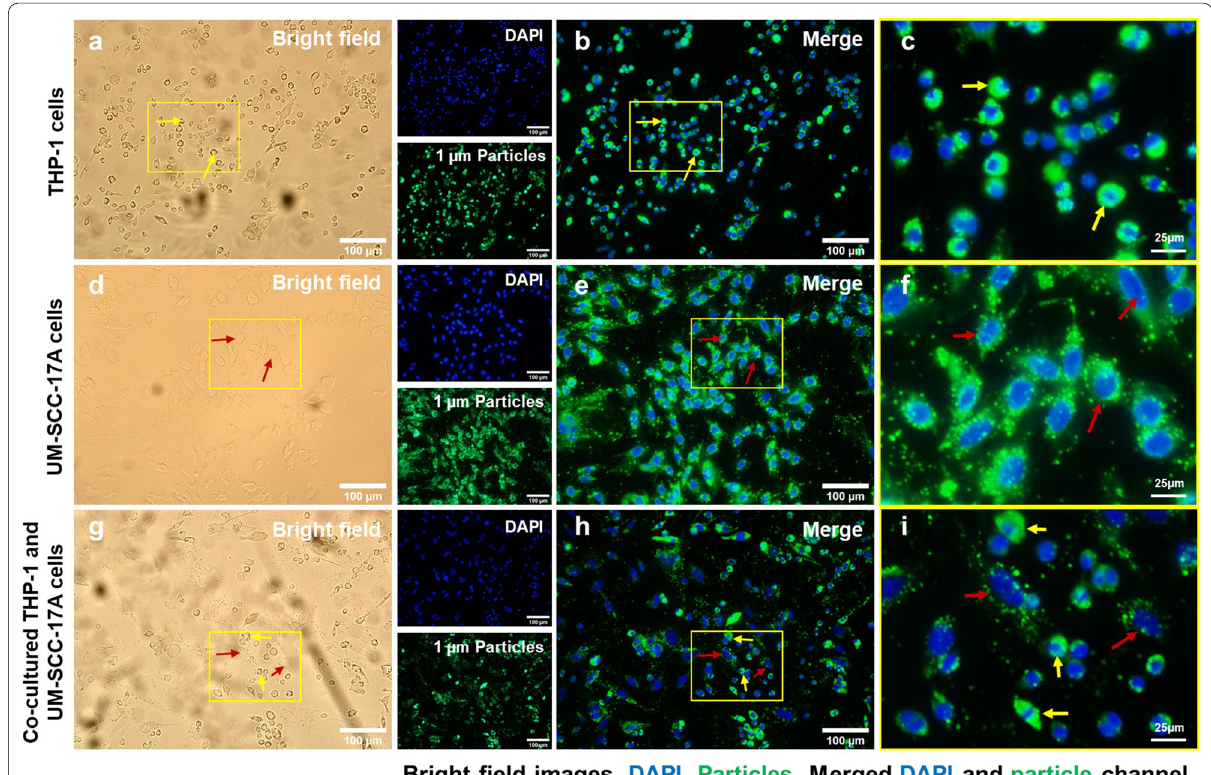
Fig. 6 Microscopic examination of cellular internalization of 1 µm PLGA particles in monoculture and co‑culture cells. Single type of cells or mixed cells was treated with 1 µm PLGA particles for 24 h at a concentration of 10 µg/mL. Cells were observed under bright‑field ( a , d , g ) and fluorescent channels ( b , e , h ) with particles observed at the green channel and cell nuclei in the blue channel after stained with Hoechst. A large amount of particle uptake and tremendous accumulation of 1 µm PLGA particles can be visualized in magnified images ( c , f , i ) for monoculture THP‑1 (yellow arrows) and UM‑SCC‑17A laryngeal cancer cells (red arrows). In the co‑culture system, 1 µm PLGA particles were still efficiently uptake by macrophages, while cancer cells had insufficient particle ingestion